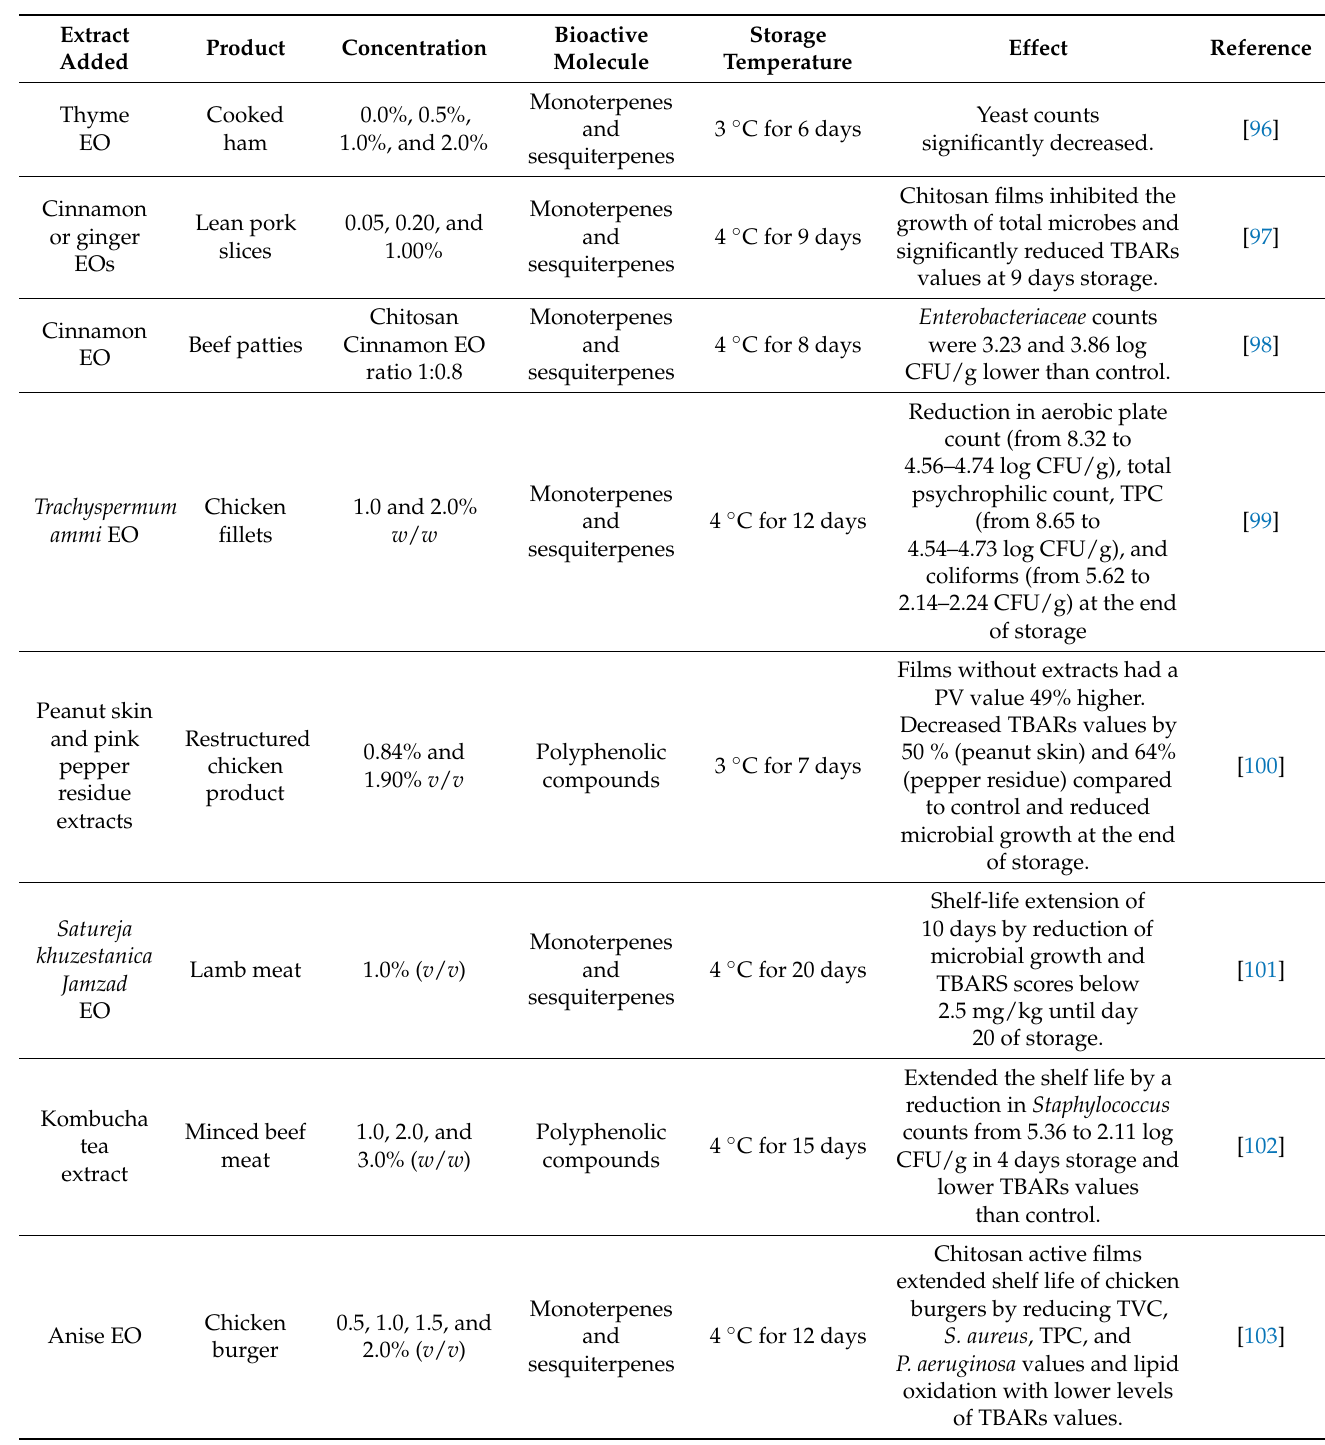
Table 3. Natural extracts added to chitosan-based films and coatings for meat and meat